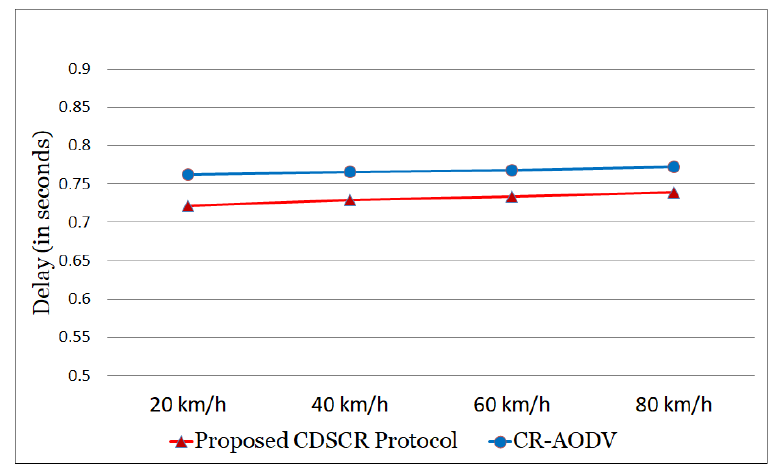
Figure 12. Delay (in second) versus node